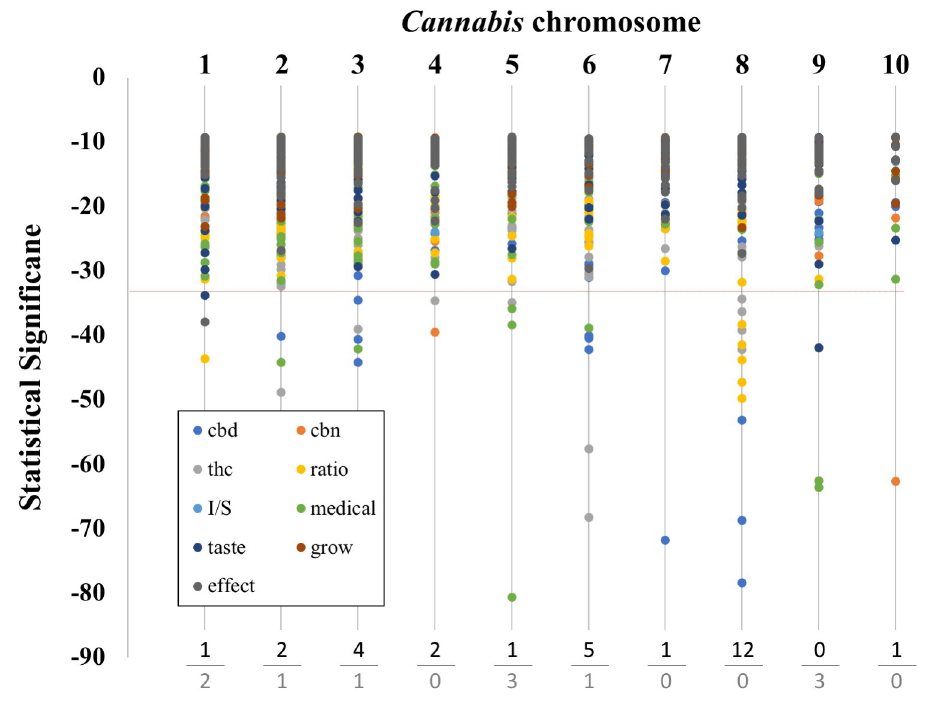
Fig 3. Bar graphs showing the number of proteins (Y axis) in various GO categories and protein classes for the indicated significant GO categories. Molecular Function GO terms are binding-GO:0005488, catalytic activity- GO:0003844, molecular transduction-GO:0060089-transcription regulation-GO: 0140110 and transporter activity- GO:005215. Cellular Component GO terms are Cell-GO:0005623, extracellular region-0005576,